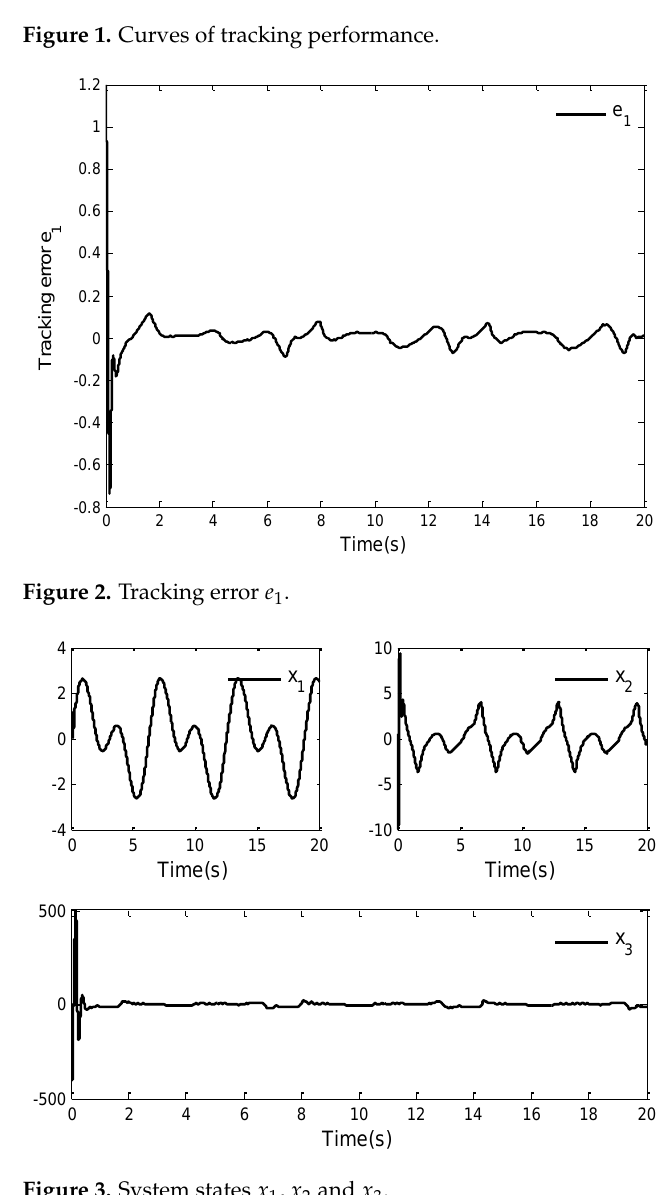
Figure 4. Control law ( ) u t .